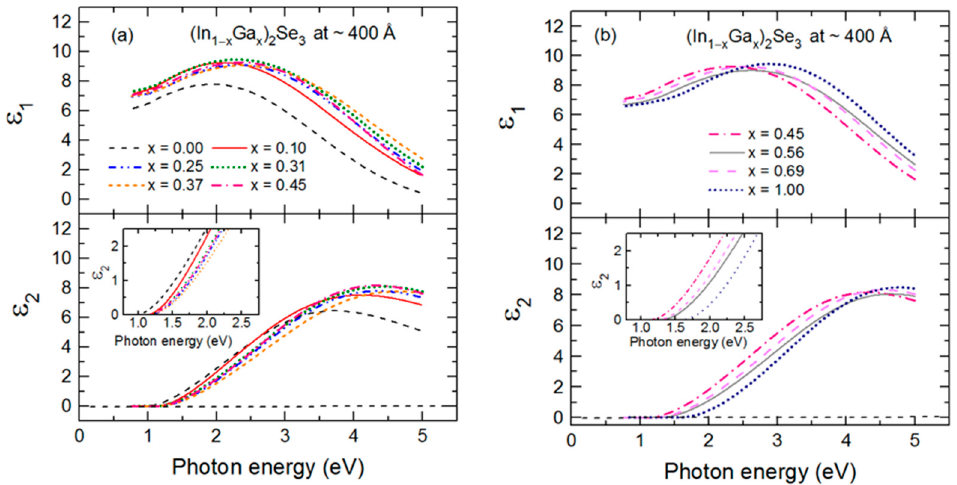
Figure 12. Parametric expressions for the complex dielectric functions ( ε 1 , ε 2 ) of ~350–410 Å thick IGS films measured at 400 °C for ( a ) x ≤ 0.45 and ( b ) x ≥ 0.45. The expressions incorporate a single Tauc-Lorentz oscillator with a high energy resonance for all the samples of different x . These ( ε 1 , ε 2 ) spectra are determined as the best fits of the results obtained by inversion at the center of the time range of the multi-time analysis.